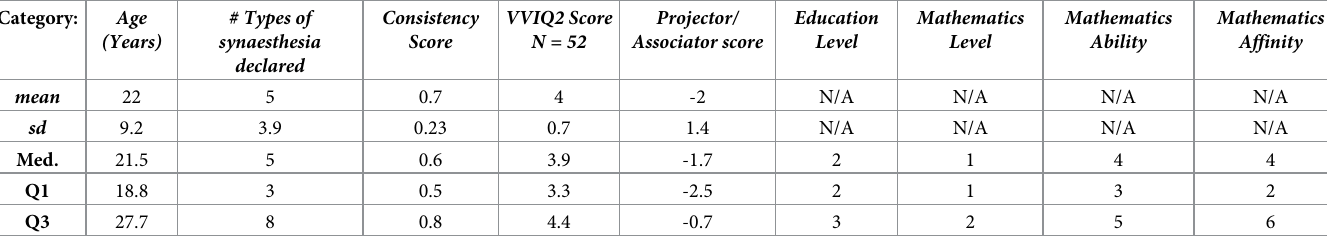
Table 1. Group experiment: Part 1—The synaesthetes’ (n = 53; 39 female and 14 male) descriptive statistics.